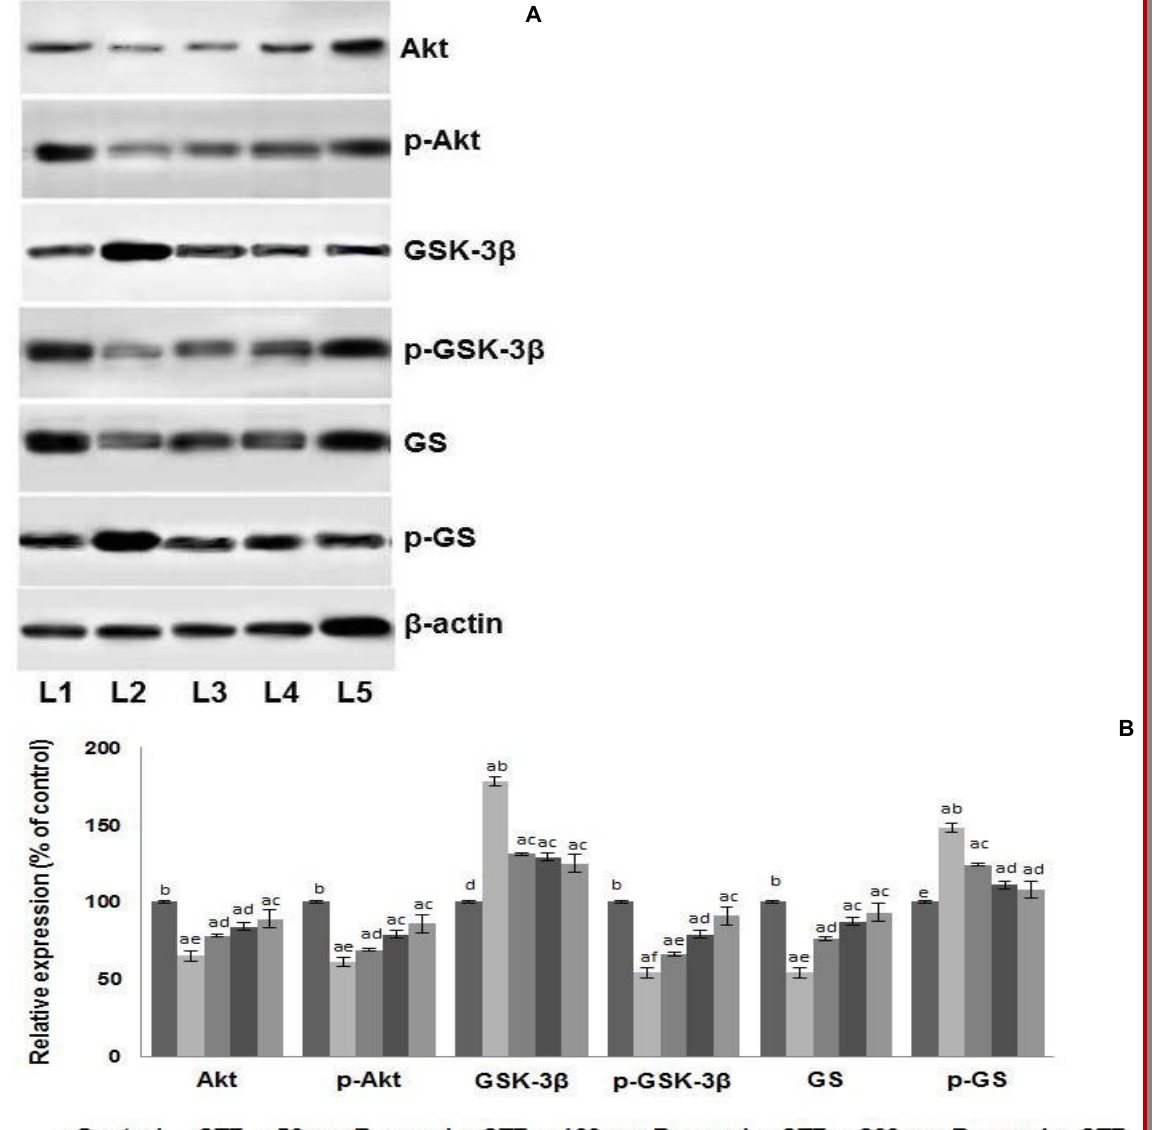
Figure 6: Influence of paeonol on the expressions of PI3K/Akt signalling pathway proteins. Paeonol markedly down-regulated active GSK-3 β and increased phosphorylated levels of Akt, GS and GSK-3 β ( A). Relative expressions of proteins (B) Values are represented as mean ± SD, n=6. a represents statistical significance at p<0.05 compared against respective controls and b-f represents significant difference (p<0.05) between mean values within the groups as determined by one-way ANOVA followed by DMRT analysis (L1-Control; L2-streptozotocin; L3-50 mg paeonol + streptozotocin; L4-100 mg paeonol + streptozotocin; L5-200 mg paeonol +